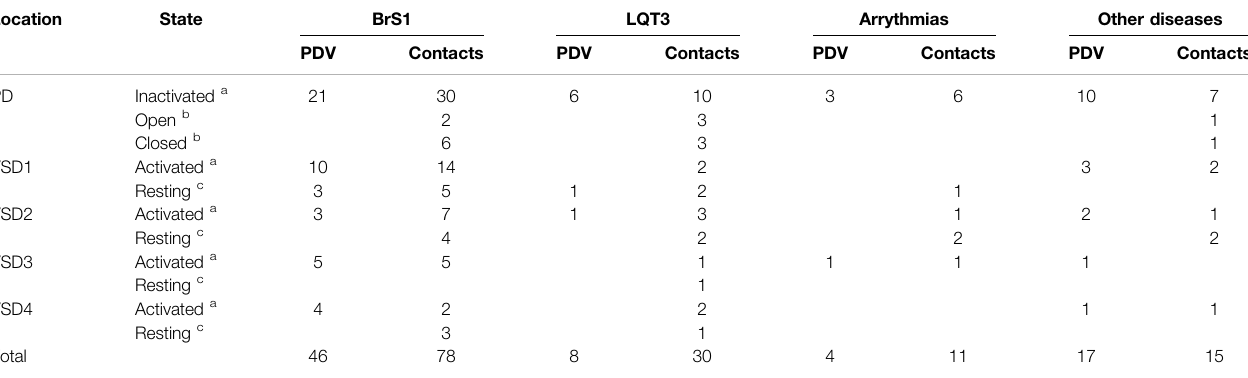
TABLE 8 | Domain distribution of disease